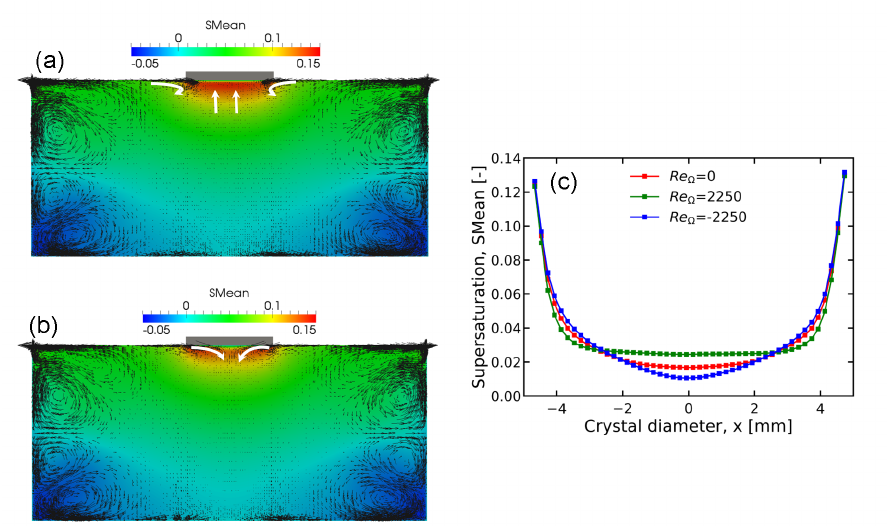
Figure 10. Time-averaged velocity vectors and supersaturation distribution in the melt at the vertical side for ( a ) Case 7 and ( b ) Case 8; ( c ) the supersaturation profiles in the melt along the seed for the cases without and with seed